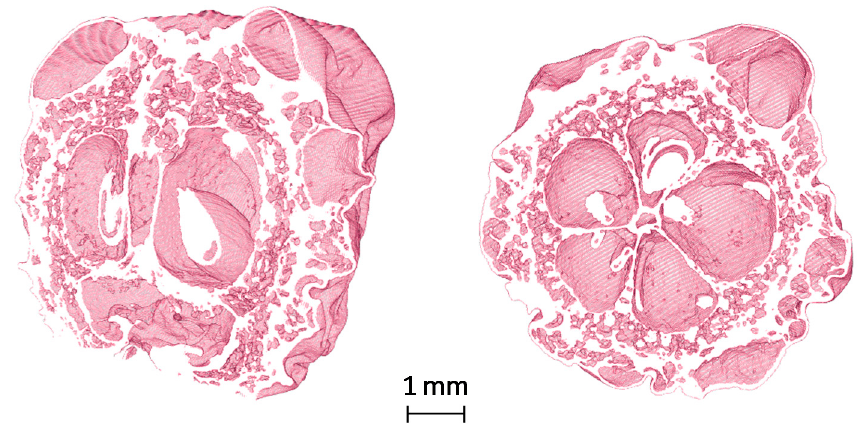
Figure 9. X-ray image of chokeberry fruit dehydrated by OD-CD-VMFD.